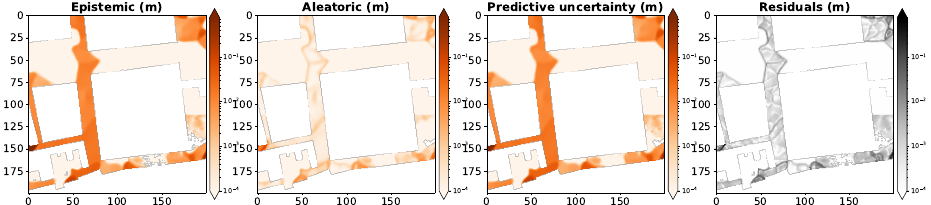
( c ) Visual comparison of epistemic, aleatoric, total predictive uncertainty, and residuals for an area of Portugal test catchment and rainfall tr2_1 . Figure 9. Qualitative evaluation of the epistemic, aleatoric and total predictive uncertainty with respect to the residual error in different catchment areas for the tr2_1 rainfall event. We can observe that both uncertainties follow the pattern of the residuals, with epistemic uncertainty being slightly higher around the edges of high water depth